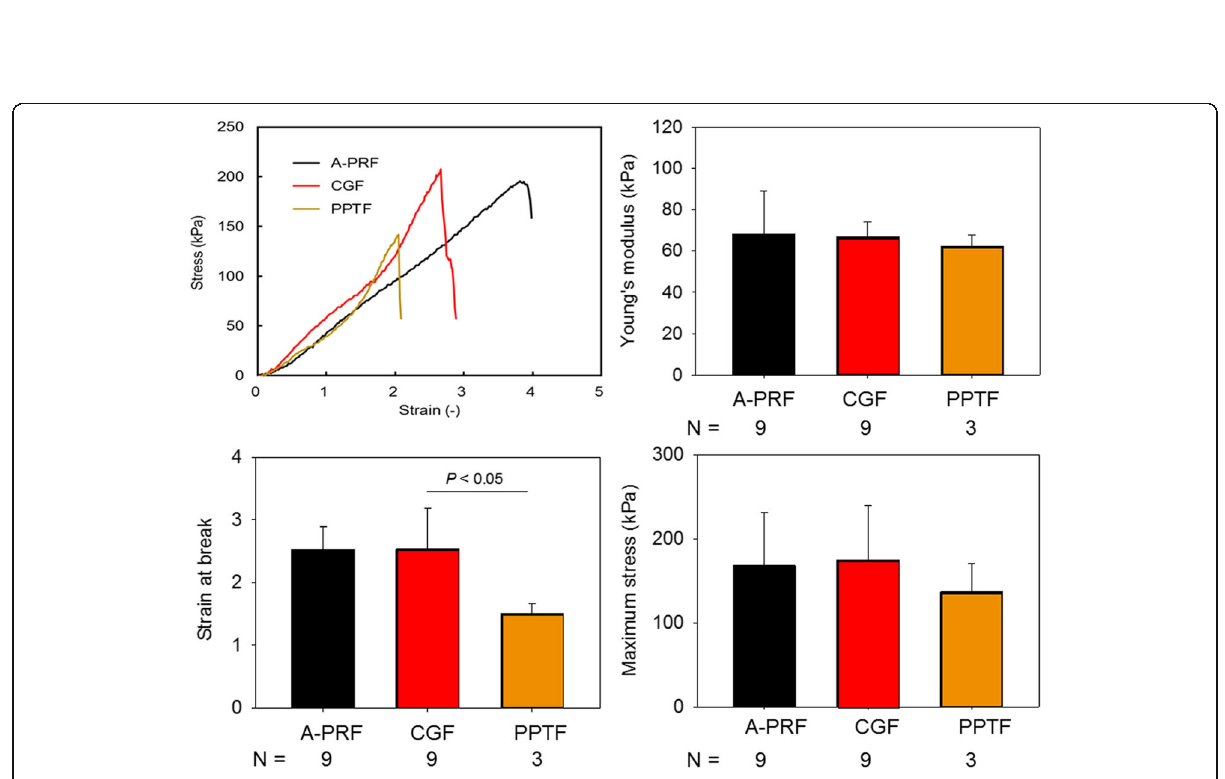
Fig. 2 Representative stress-strain curves for A-PRF and CGF membranes and mechanical properties (Young ’ s modulus, strain at break, and maximum stress) of A-PRF, CGF, and PPTF membranes. N =3 –